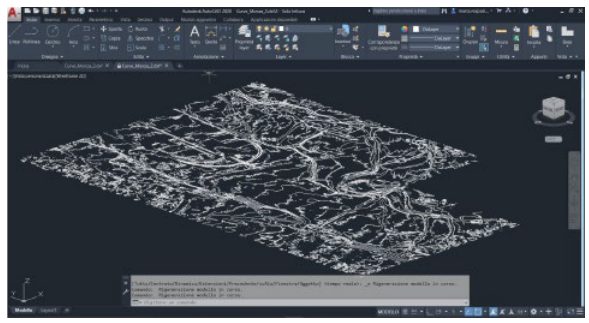
Figure 3 . Imported Contour Lines in Autocad.